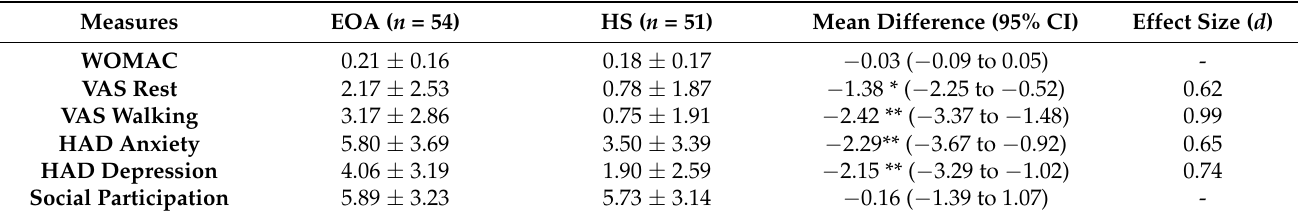
Table 3. Between-group